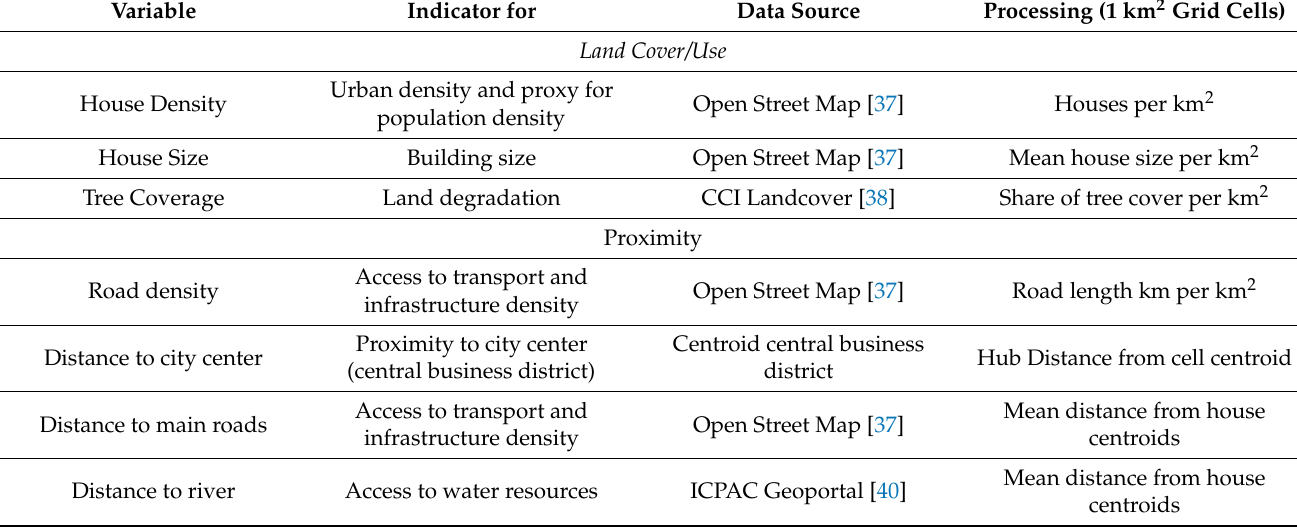
Table 1. Indicators calculated for spatial pattern